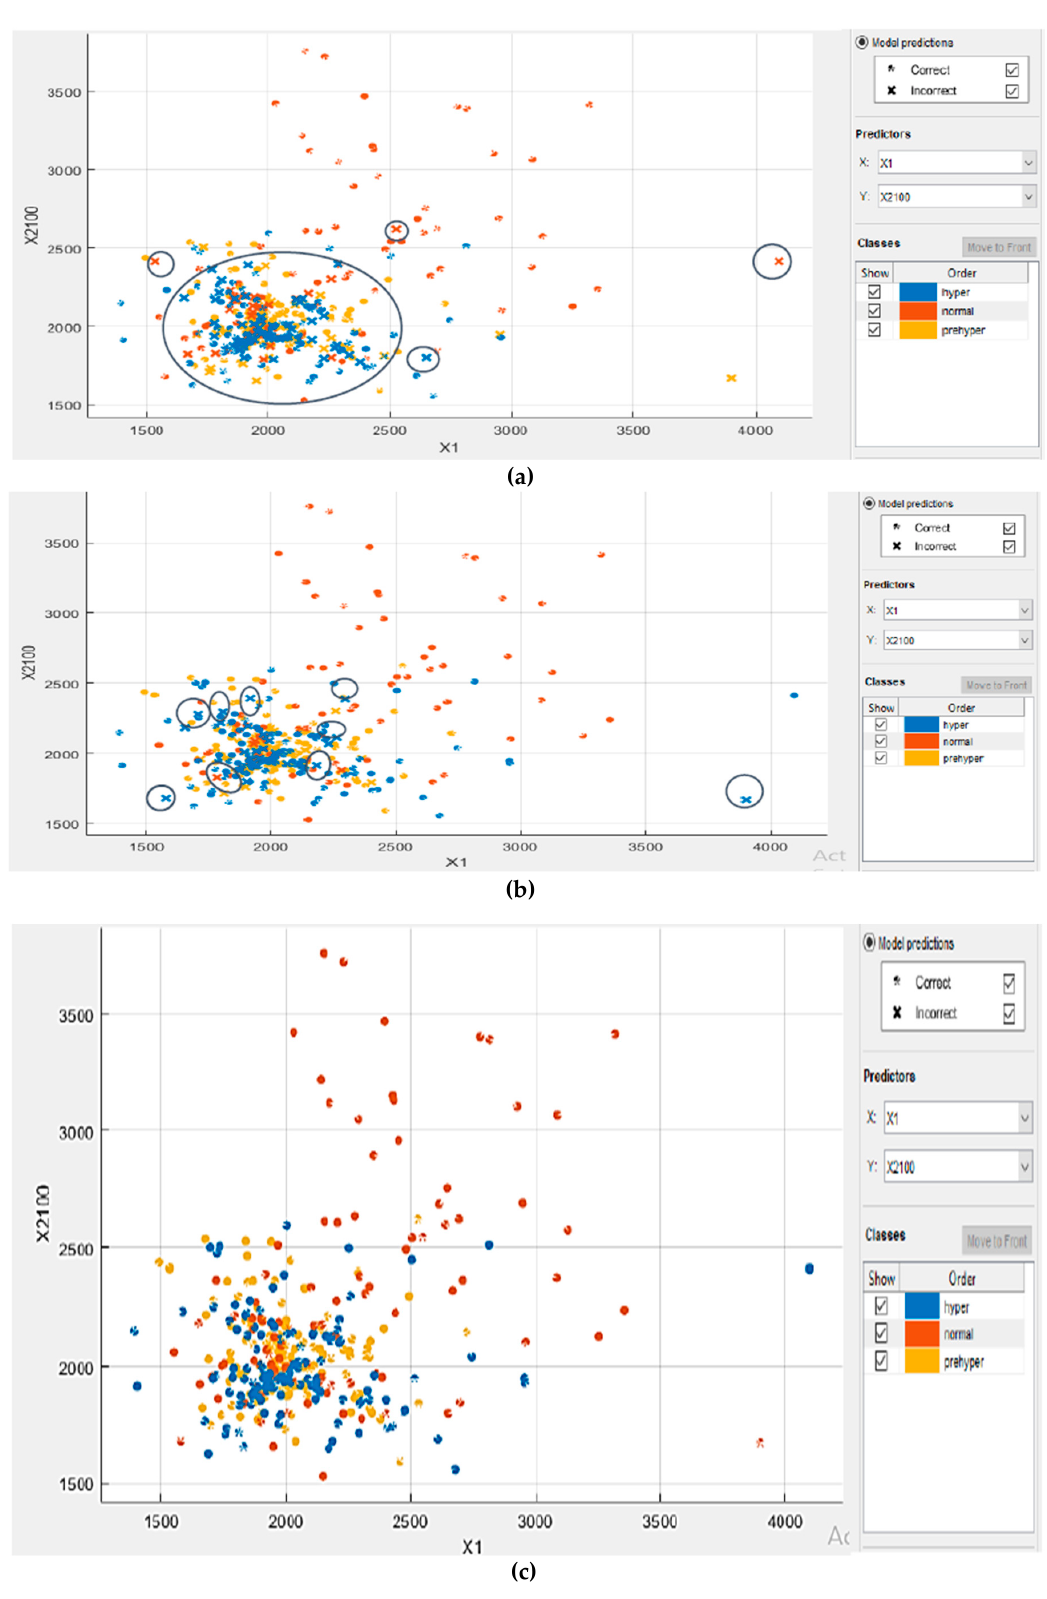
Figure 9 . The coordinates of the points (1200–4100) are scattered according to their respective classifications.